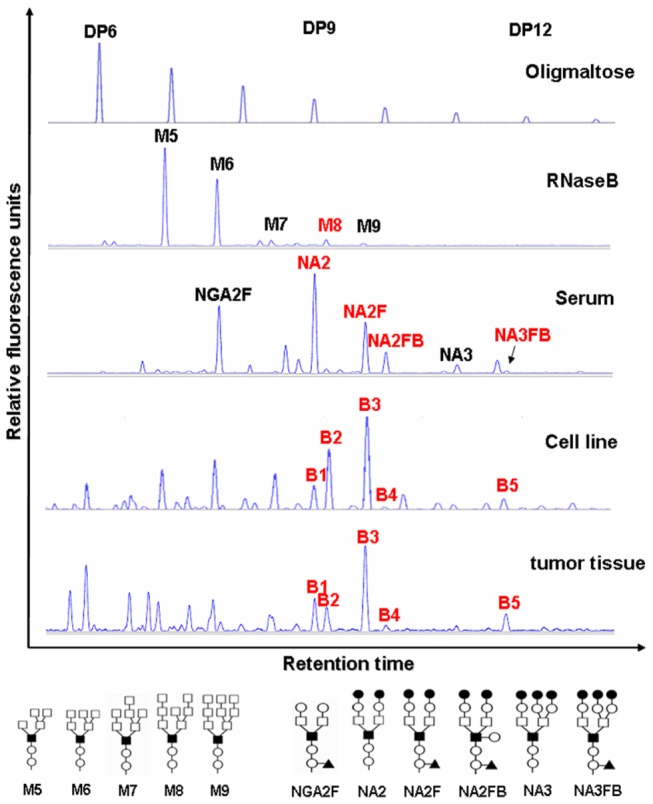
The representative N-glycan profiles of membrane proteins from human breast cancer cell line and tissue.The desialylated N-glycan profiles of membrane proteins from cell lines (n=8) and tumor tissues (n=100). Oligomaltose is used as a sugar mass reference. The number of glucose units (degree of polymerization, DP) in these structures is indicated. N-glycan profiles from RNaseB and serum were used as N-glycan profile controls. RNaseB contained high mannose from M5 to M9. Serum contained various complex N-glycans and the most abundant glycans detected in serum are marked. The vertical axis represents the glycan intensity of the peaks as a percent of the relative fluorescence level. The X-axis represents the retention time of the peaks. The N-glycan structures of the corresponding peaks are shown below the panels. NGA2F is an agalacto core-α-1, 6-fucosylated biantennary glycan; NA2 is a bigalacto biantennary glycan; NA2F is a bigalacto core-α-1, 6-fucosylated biantennary glycan; NA2FB is a bigalacto core-α-1, 6-fucosylated bisecting biantennary glycan; NA3 is tri-antennary; NA3FB is a core-α-1, 6-fucosylated triantennary glycan. The symbols used in the structural formulas are as follows: (○) β-linked N-acetylglucosamine; (●) β-linked galactose; (□) α-linked mannose; (■) β-linked mannose; (▲) α-1, 6-linked fucose.